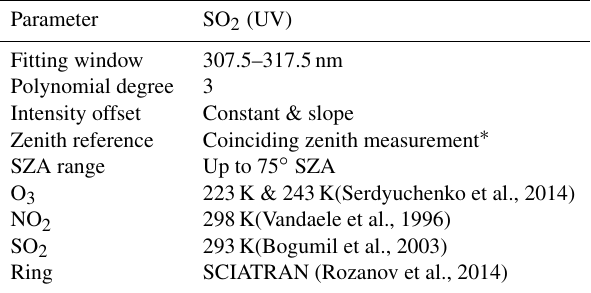
Table 2. DOAS fit settings for the retrieval of NO 2 and O 4 in the UV and visible spectral